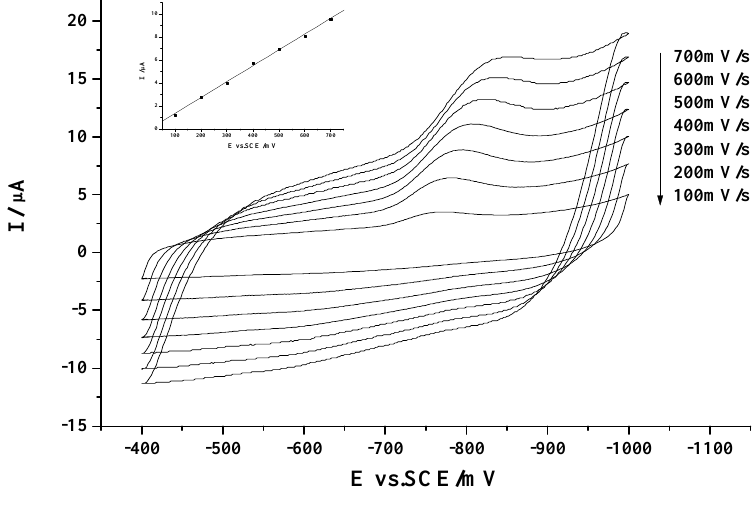
Figure 2. Cyclic voltammograms of camptothecin at scan rates varying from 100 to 700 mV s -1 (from inner to outer), and plot of the cathodic peak current against the scan rate (inset). Others same as